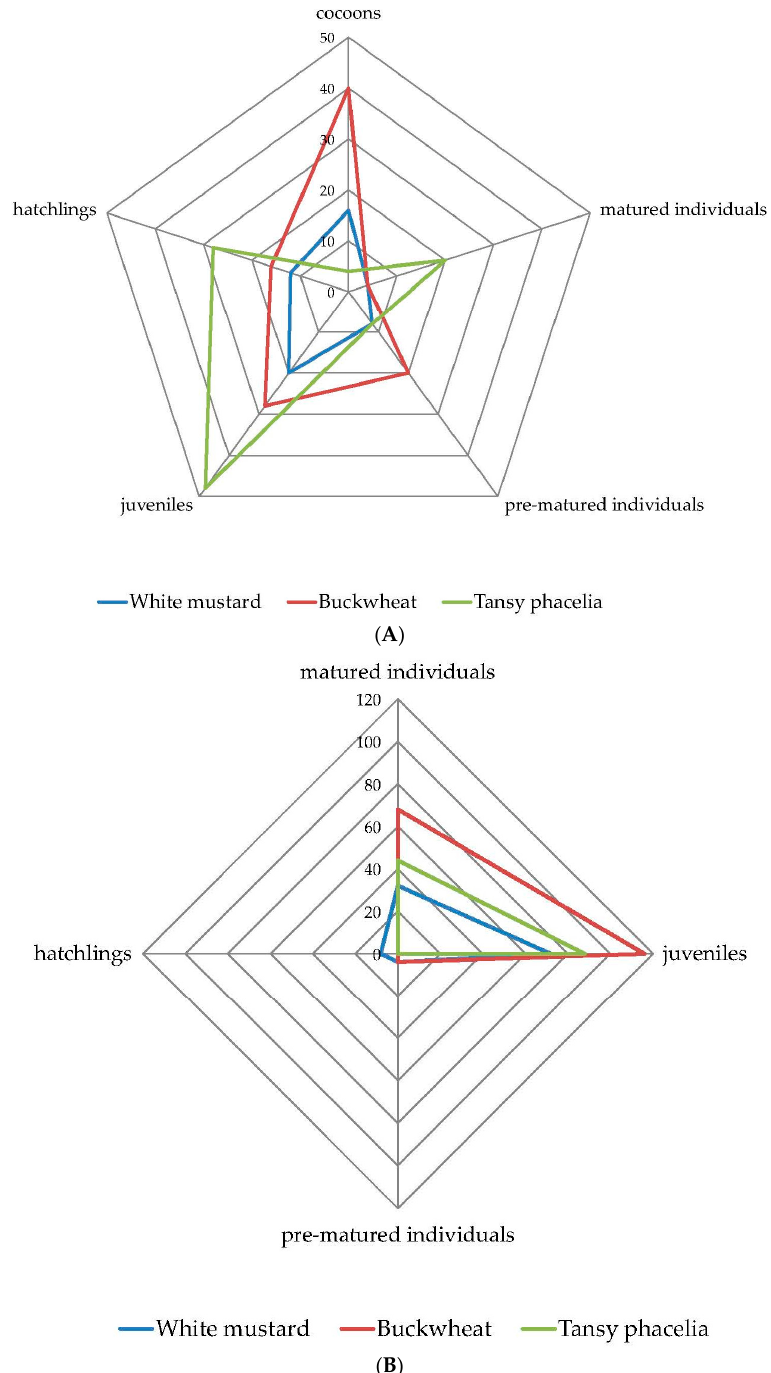
Figure 3. Earthworm’s life cycle abundance and their changes within 10 weeks, ( A ) after triticale harvest, ( B ) in stubble crops. harvest, ( B ) in stubble